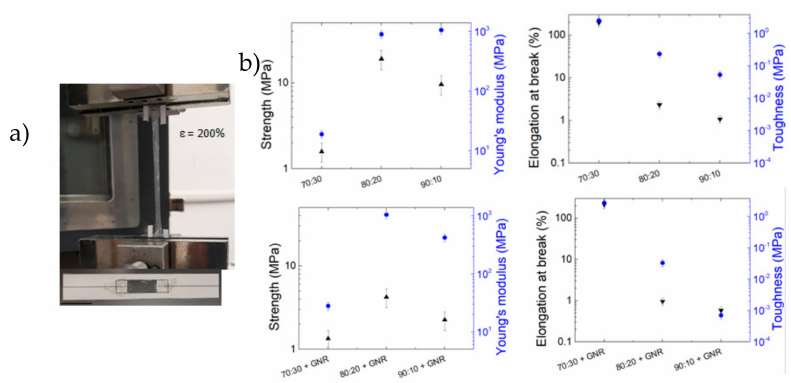
Figure 2. ( a ) Photograph of the 70:30 RS-GNR film glued on rectangular paper frame (scale bar at the bottom indicates 3 cm) and stretched 3 times the original length. ( b ) E ff ect of Ca content and GNR addition on strength, modulus, elongation at break and toughness of the RS films.